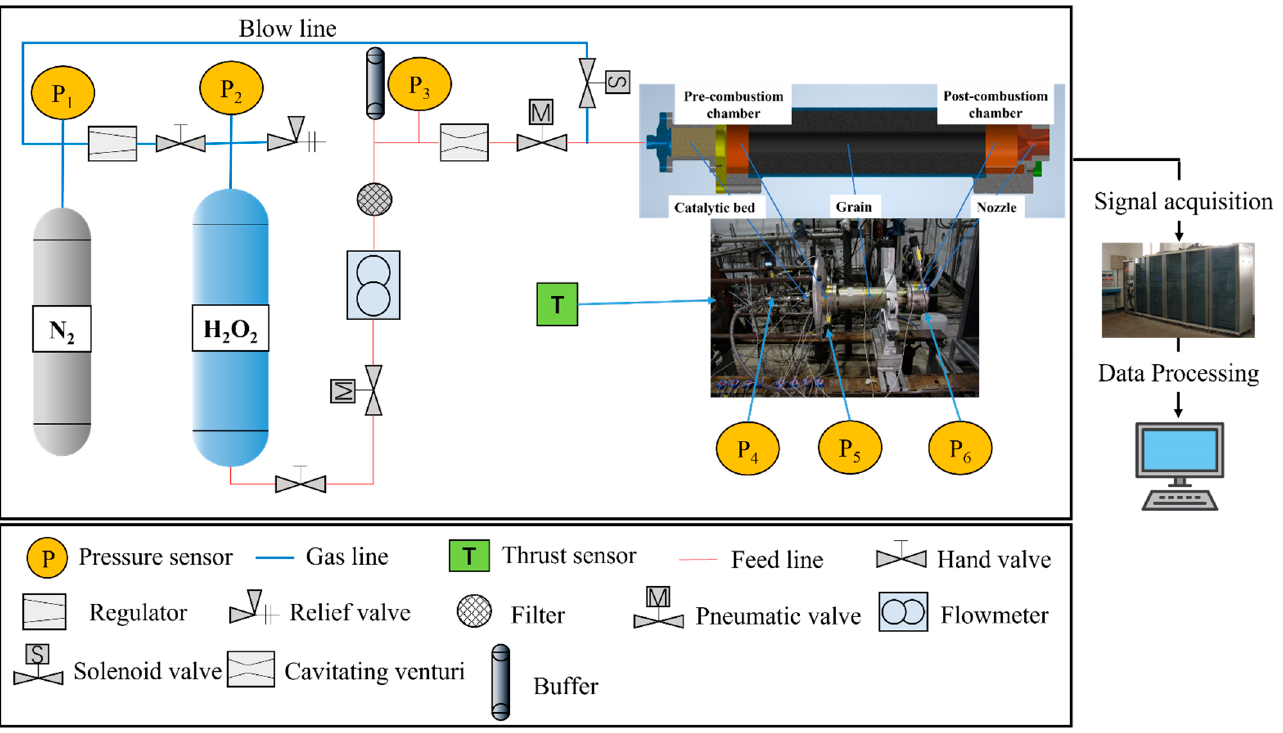
Figure 1. Schematic of the test system. Table 1. Solid fuel formulas and nozzle material of the test motor.